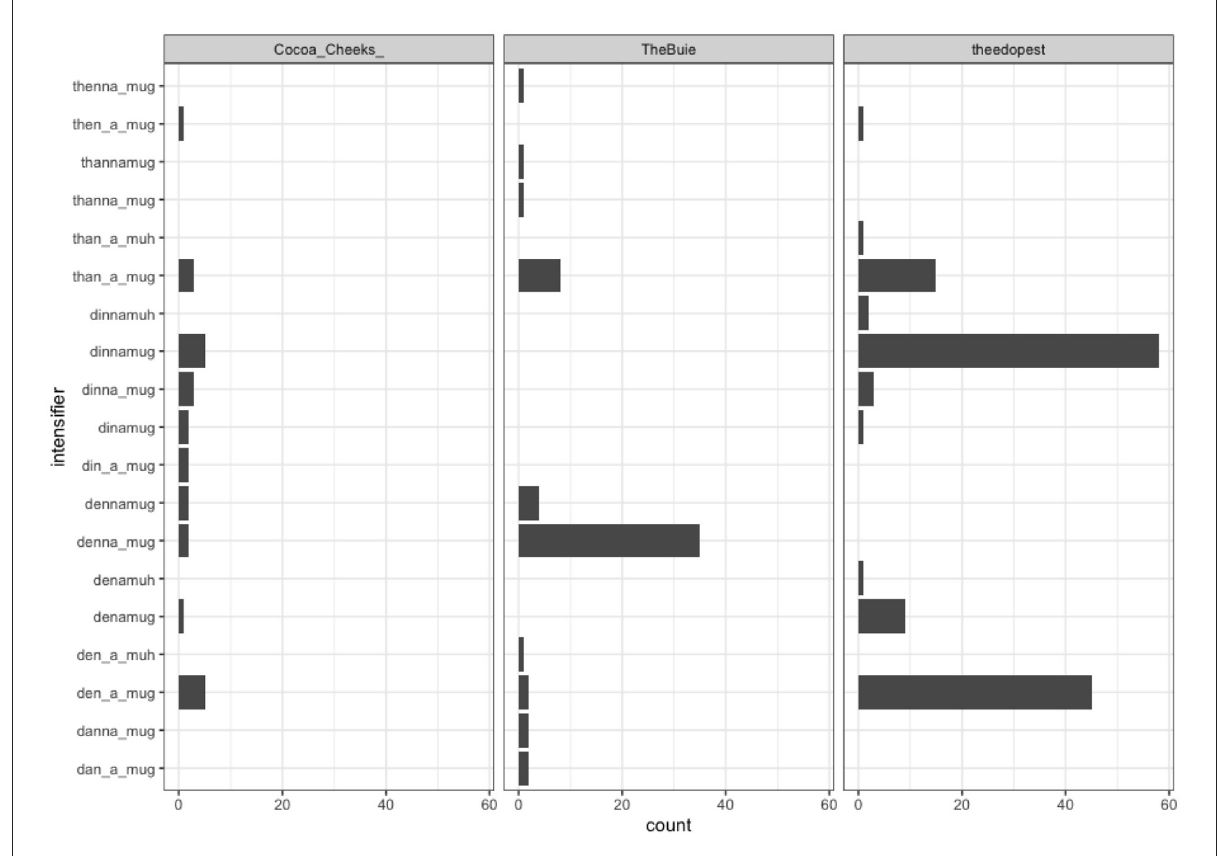
FIGURE6 Orthographic choices for authors who used 10 different